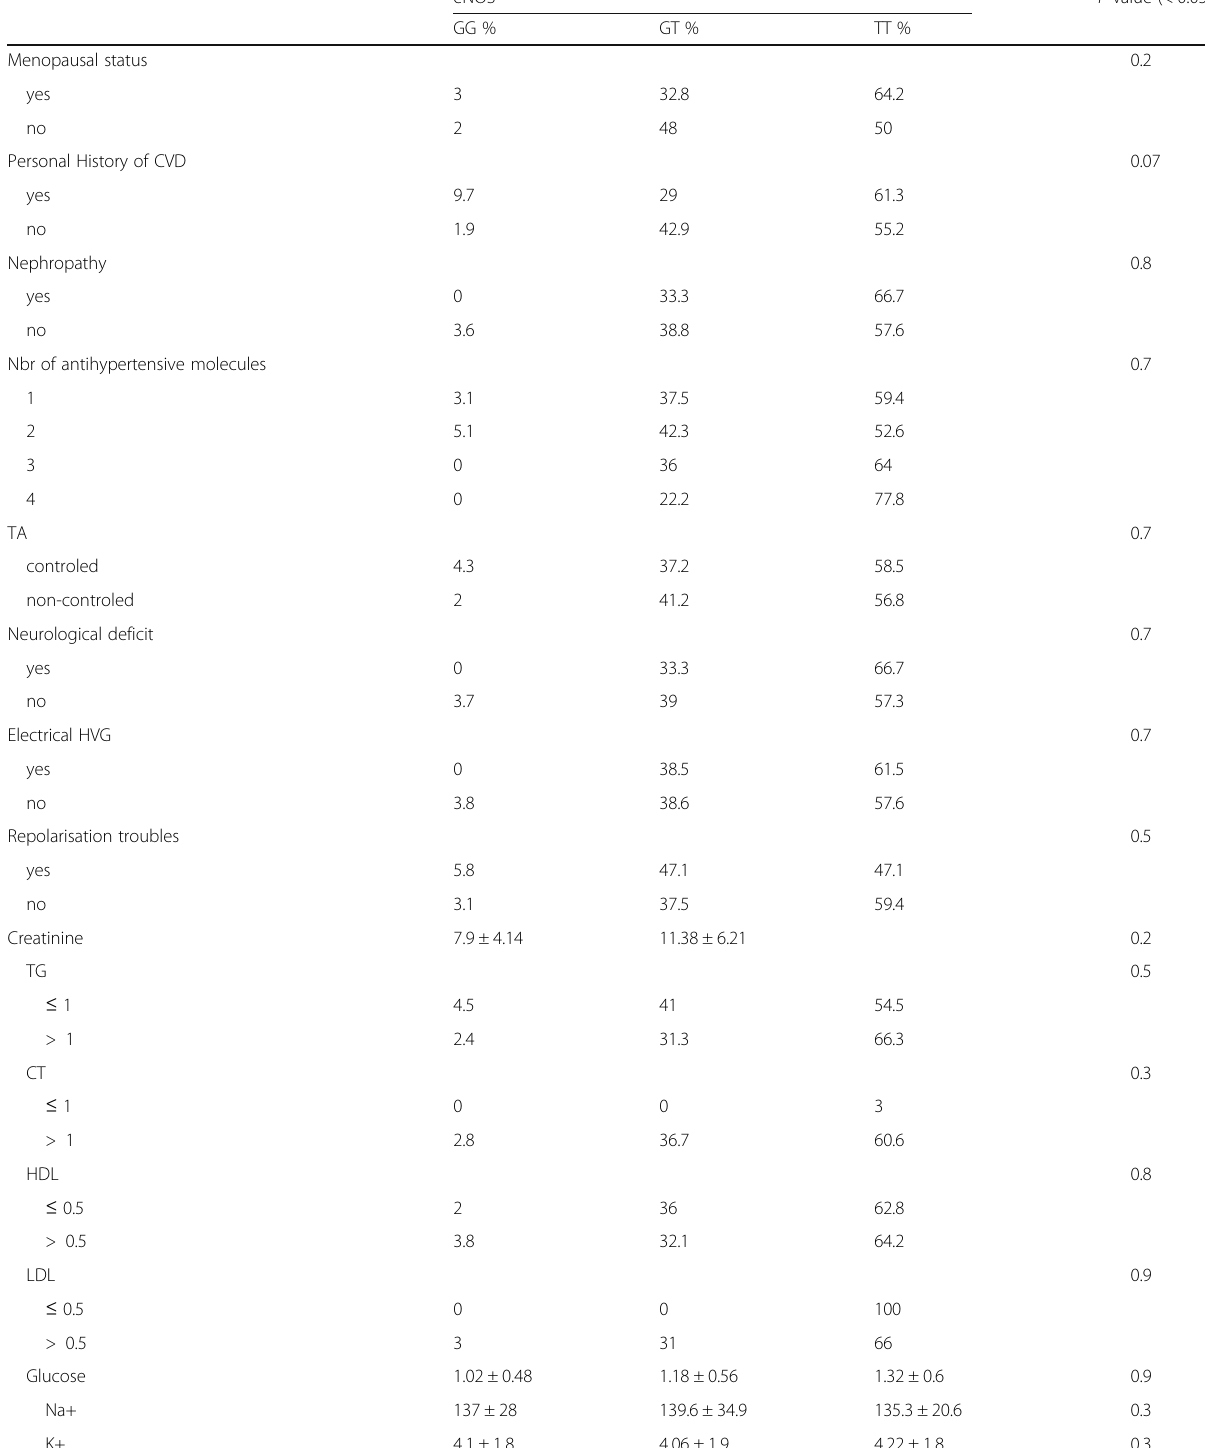
Table 1 G894 T eNOS distribution Vs Clinical parameters